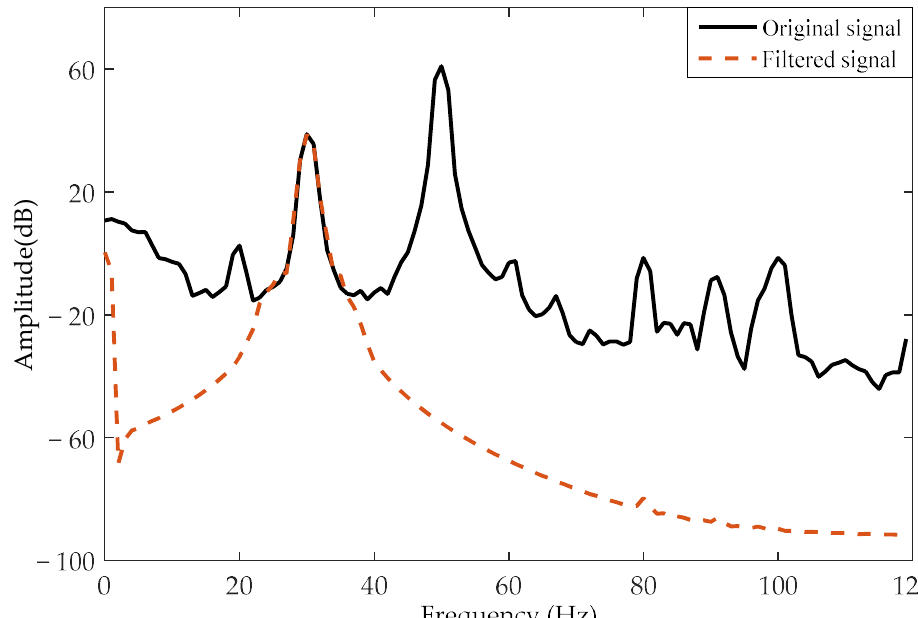
Figure 13. The spectrum of the output signal before and after filtering.